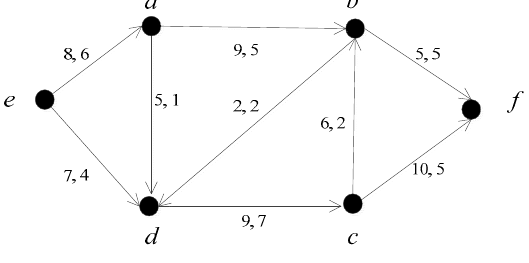
Figure 2. Flow network diagram.